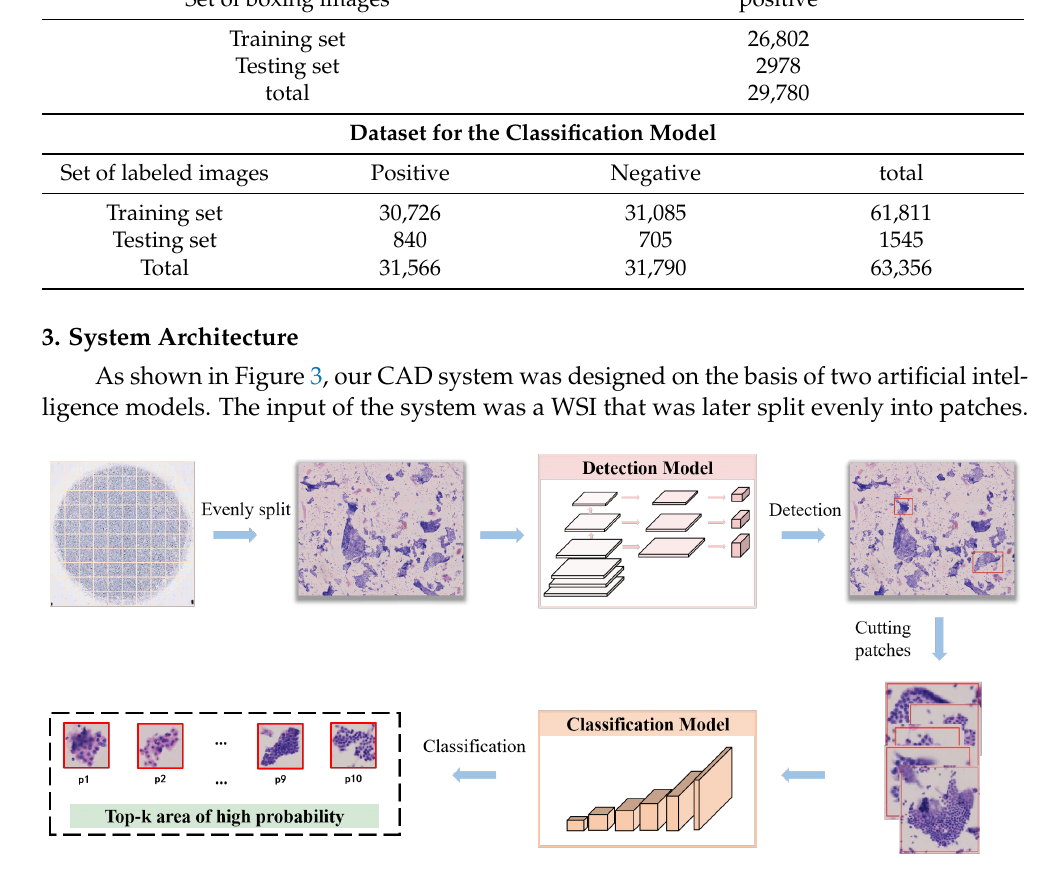
Figure 3. The workflow of our proposed